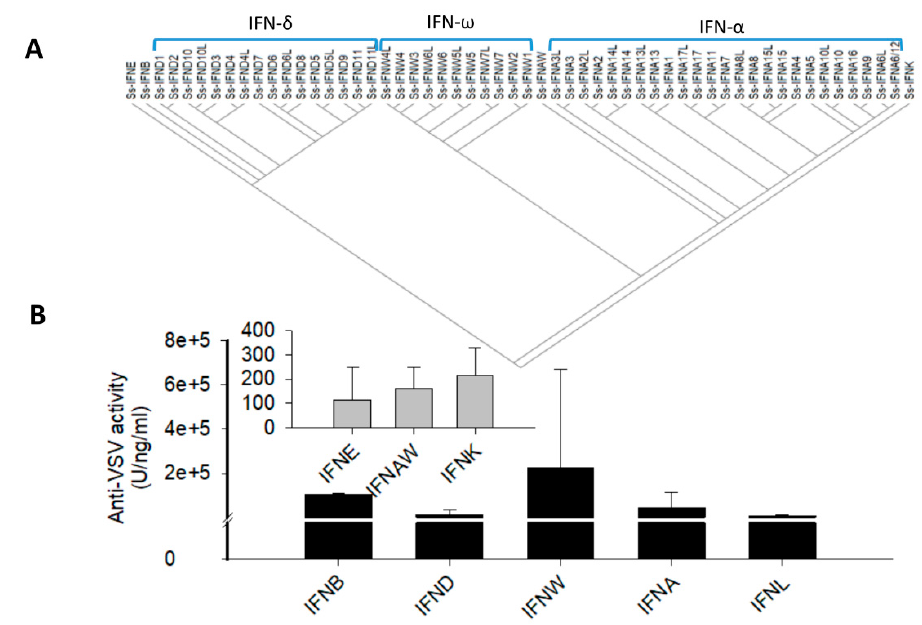
Figure 4. (A) Phylogenic topology of major porcine type I IFN genes including recently identified duplicates [33]. Evolutionary analyses were conducted in MEGAX to show tree topology and